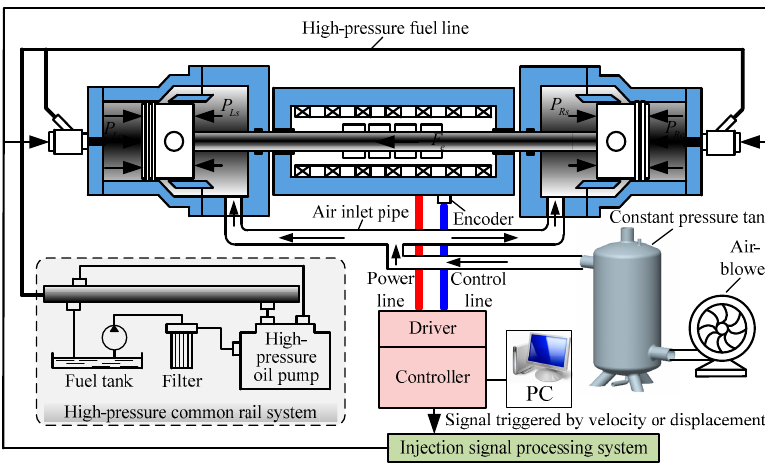
Figure 1. Functional schematic of the FPLG experiment rig.